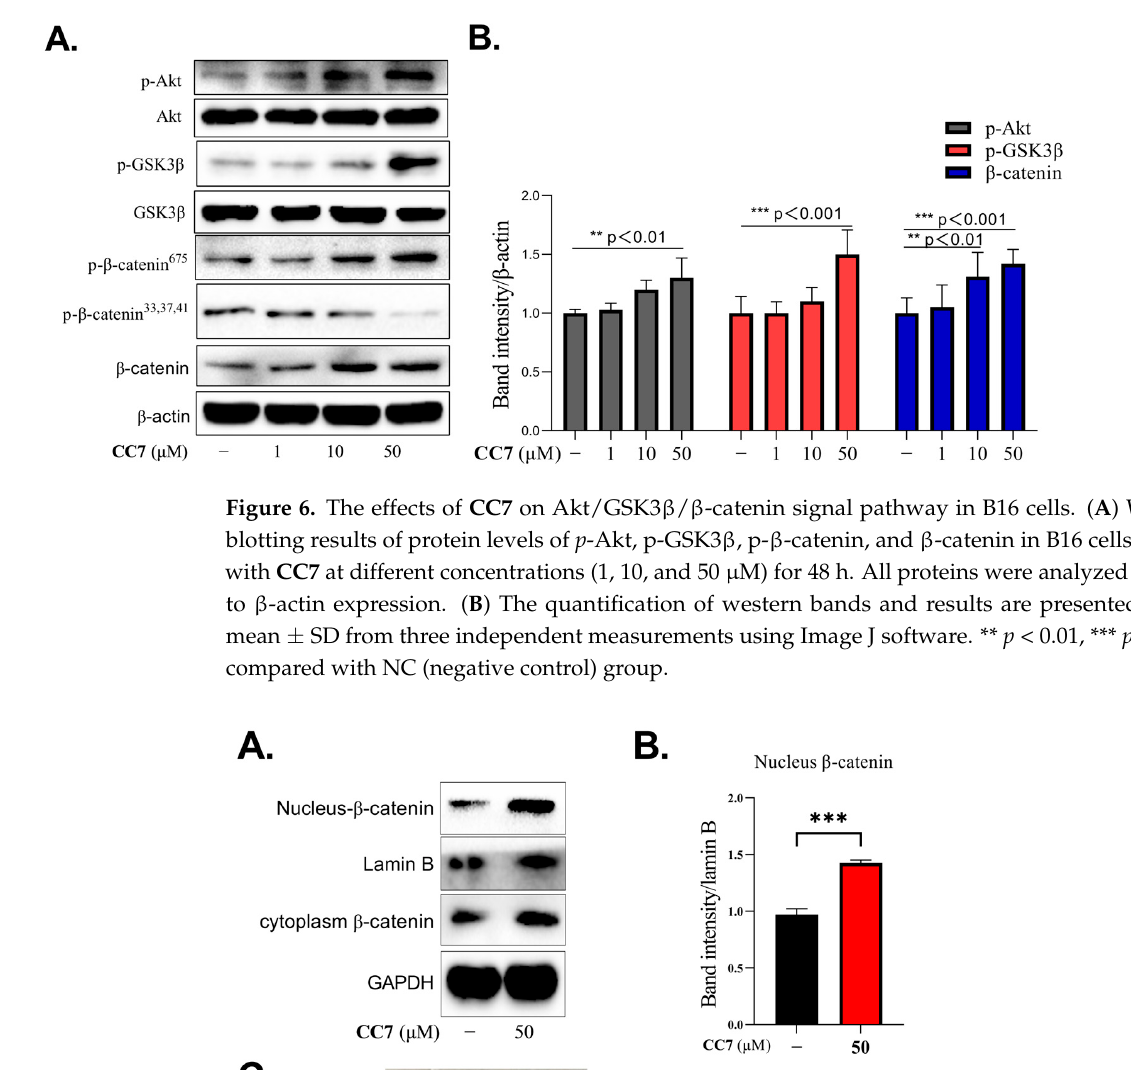
Figure 6. The effects of CC7 on Akt/GSK3 β / β -catenin signal pathway in B16 cells. ( A ) Western blot- ting results of protein levels of p -Akt, p-GSK3 β , p- β -catenin, and β -catenin in B16 cells treated with CC7 at different concentrations (1, 10, and 50 μ M) for 48 h. All proteins were analyzed relative to β - actin expression. ( B ) The quantification of western bands and results are presented as the mean ± SD from three independent measurements using Image J software. ** p < 0.01, *** p < 0.001 compared with NC (negative control) group.